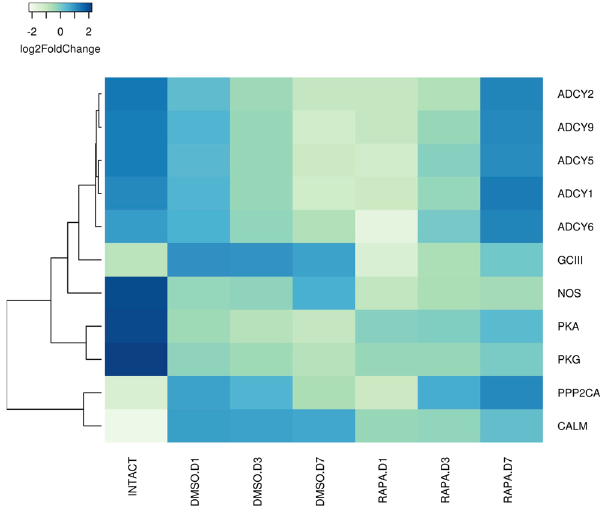
Figure 8. DEGs in the G . lateralis YO/I/DRESA transcriptome implicated in MIH signaling pathway 5,7,11 . Heat map showing the log2-fold change of the FPKM values of the DEGs. KAAS was used to identify genes annotated by BLAST against the specific insect database (Section 4.5) and assigned to a KEGG pathway 38–40 .